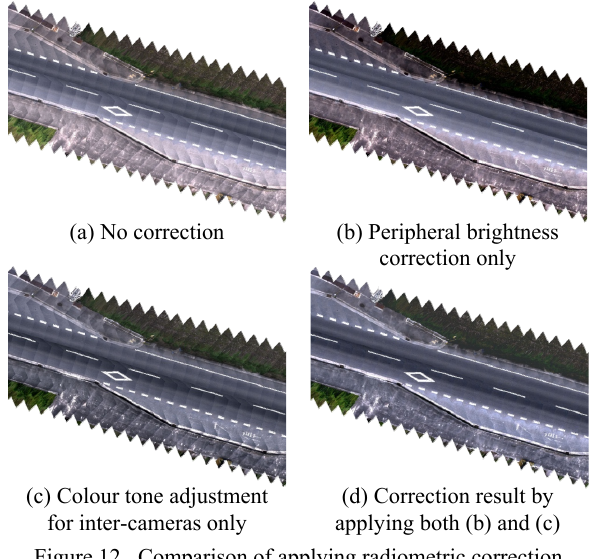
Figure 14. Effectiveness of image masking and